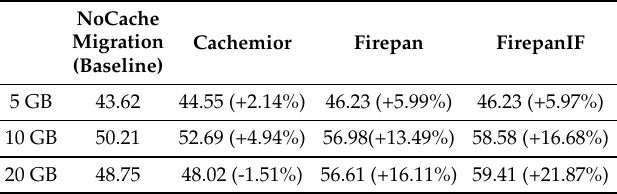
Table 2. Average bandwidth during 400 s after VM migration.